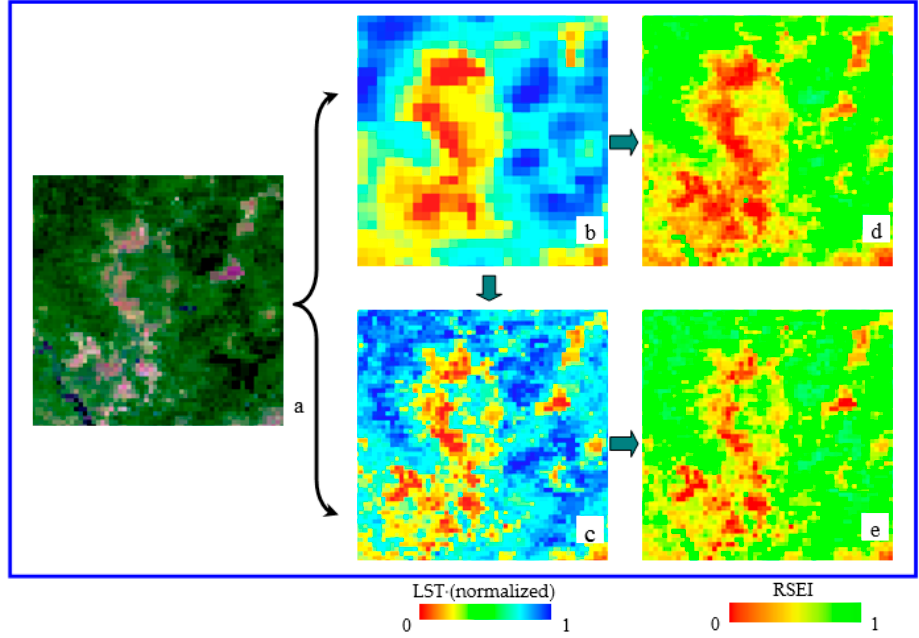
Figure 9. Comparison between RSEI-shp and RSEI-nonshp. ( a ) original image, ( b ) original 1000 m LST image, ( c ) sharpened 500 m LST image, ( d ) RSEI-nonshp image computed using the 1000 m LST image, ( e ) RSEI-shp image computed with the sharpened 500 m LST image.